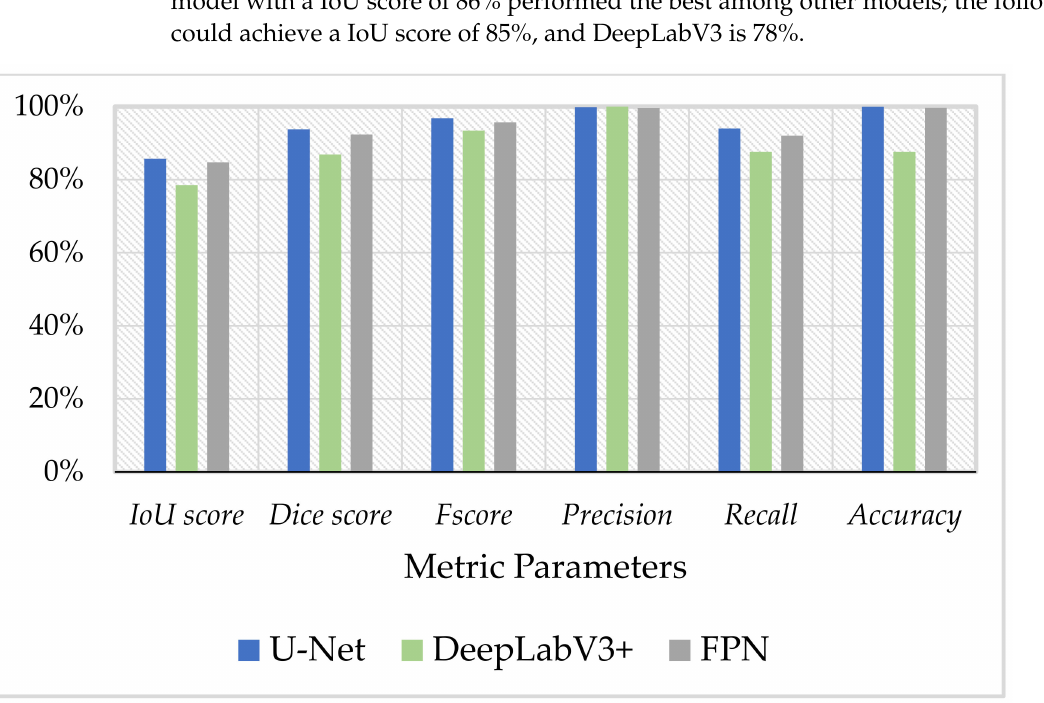
Figure 7. Segmentation models’ performance evaluation